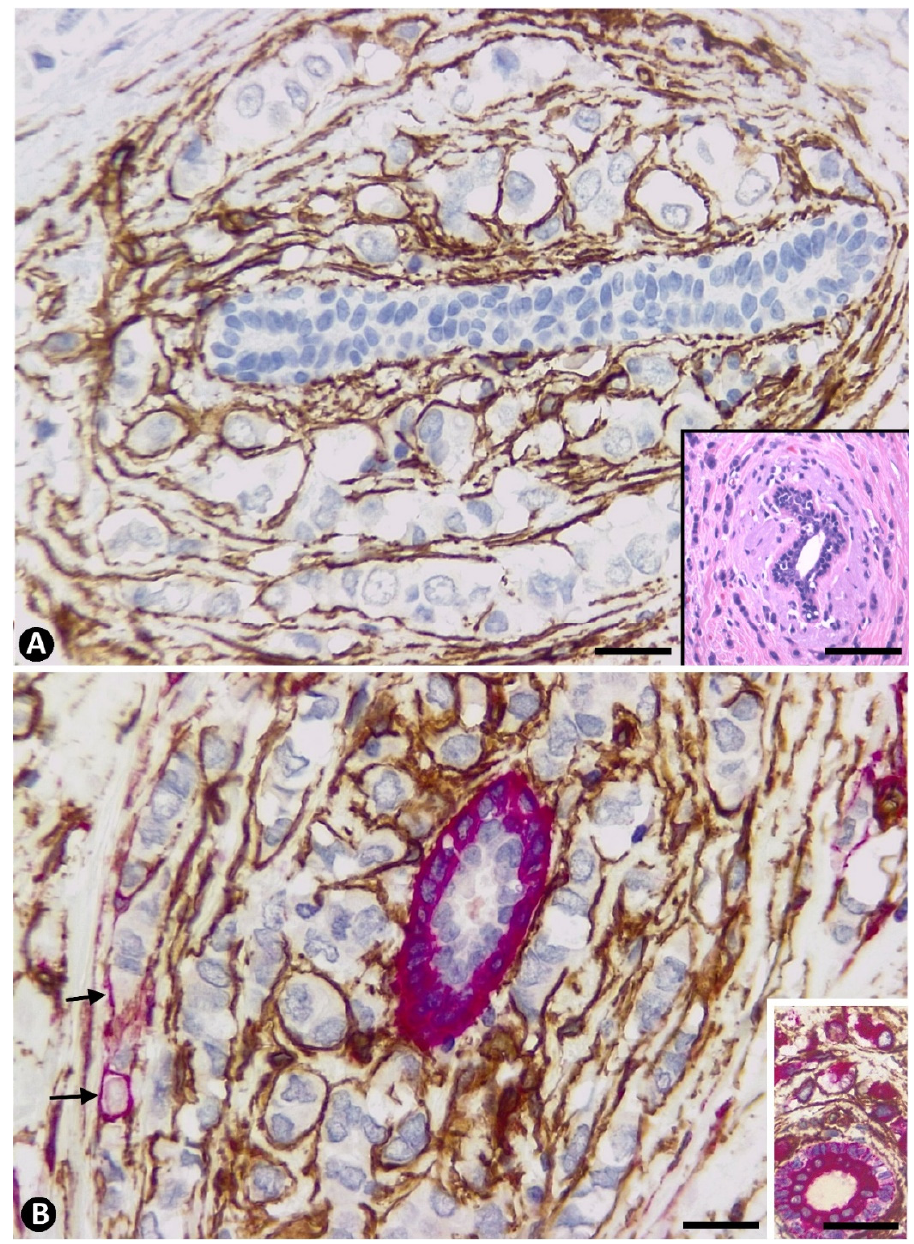
Figure 4. ( A ): Immunochemistry staining for CD34. Haematoxylin counterstain. Rings of CD34+SCs (brown) surrounding neoplastic cells around a glandular duct. Insert: a duct with the peripheral rings of neoplastic cells, which is virtually diagnostic of invasive lobular carcinoma in Haematoxylin-eosin staining. ( B ): Double immunochemistry staining for CD34 (brown) and α SMA (red). Haematoxylin counterstain. Abundant CD34+ (brown) and scarce SMA+ (red, arrows) stromal cells around a duct with α SMA+ myoepithelial cells. Insert: Double immunochemistry staining for CD34 (brown) and cytokeratin AE1/AE3 (red). Epithelial cells of the duct and neoplastic cells express cytokeratin AE1/AE3 (red) and stromal cells express CD34 (brown). Bar: ( A , B ): 30 µm; Insert of ( A ): 120 µm and Insert of ( B ): 80 µm.